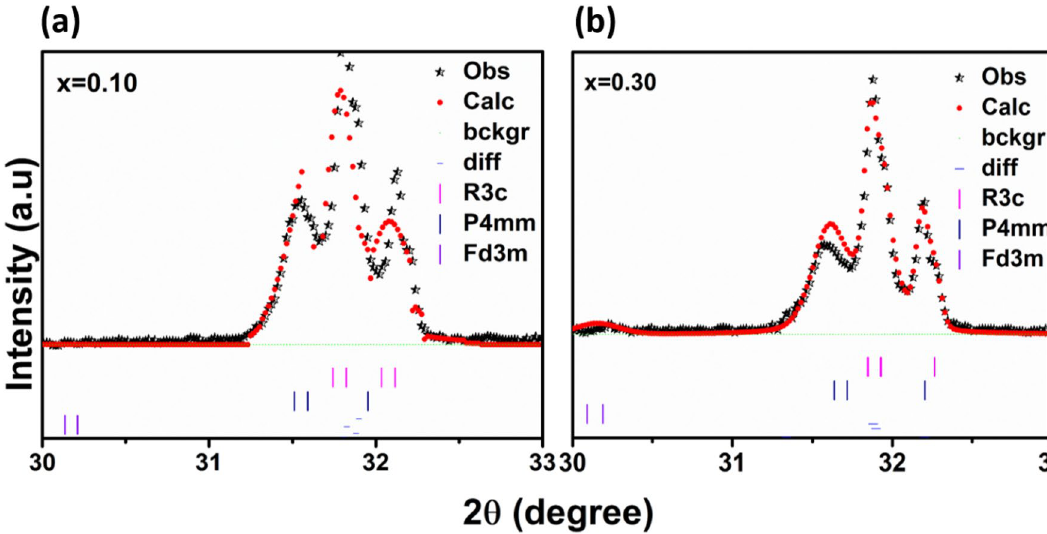
Figure 3. The refined profiles using the (a,b) R3c + P4mm + Fd3m symmetries across the (110) T and (104)/ (110)